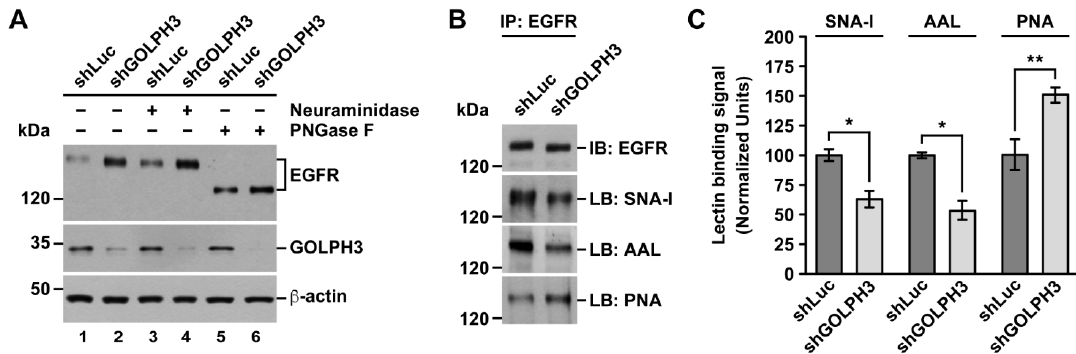
Figure 2. The knockdown of GOLPH3 perturbs the glycosylation processing of EGFR in T98G cells. ( A ) Detergent-soluble extracts were prepared from the indicated cells grown in 6-well plates, and samples were either left untreated (lanes 1 and 2), treated with Neuraminidase (lanes 3 and 4), or treated with PNGase F (lanes 5 and 6), followed by SDS-PAGE and immunoblot analysis using antibodies to detect the proteins indicated on the right. The immunoblot signal of anti- β -actin was used as the loading control. The position of molecular mass markers is indicated on the left. ( B ) Detergent-soluble extracts were prepared from the indicated cells, followed by immunoprecipitation (IP) of EGFR. Immunoprecipitated EGFR was analyzed by SDS-PAGE followed by either immunoblot (IB) to EGFR or lectin blot (LB) using the lectins indicated in the right: Sambucus nigra lectin (SNA-I), Aleuria aurantia lectin (AAL), and Peanut agglutinin (PNA). The position of a molecular mass marker is indicated on the left. ( C ) Densitometry quantification of the immunoblot or lectin blot signal as shown in B. Bars represent the mean ± standard deviation ( n = 3; * p < 0.05; ** p < 0.01).